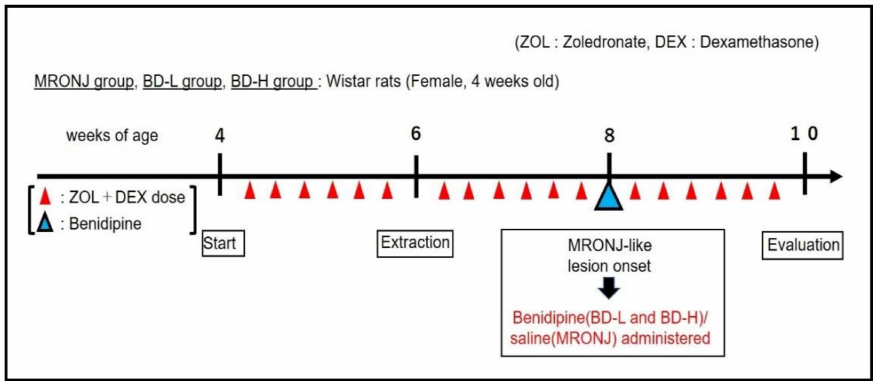
Figure 4. Experiment